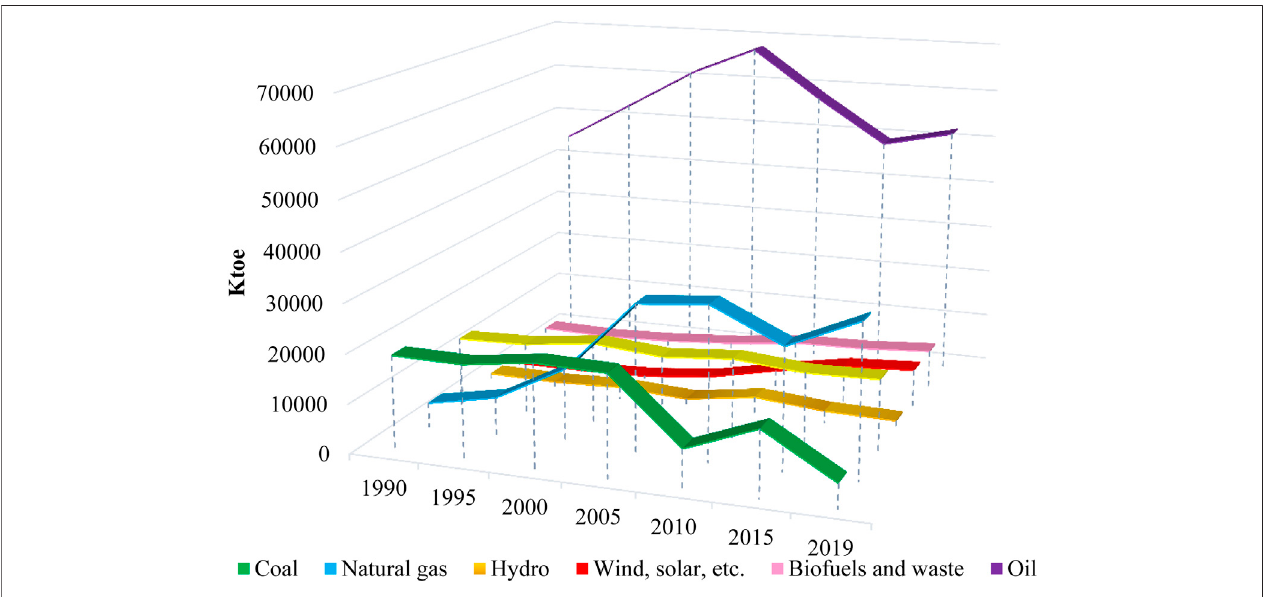
FIGURE 1 | Total energy supply (TES) by source, Spain 1990 –